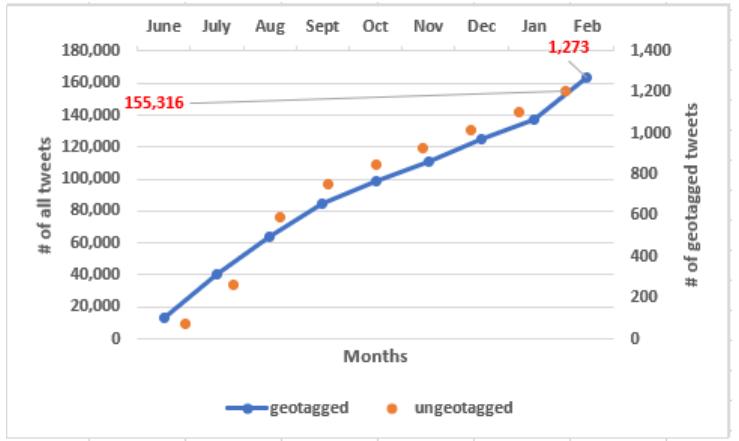
Figure 7. Cumulative value of geotagged tweets collected for this research (include multilin- gual